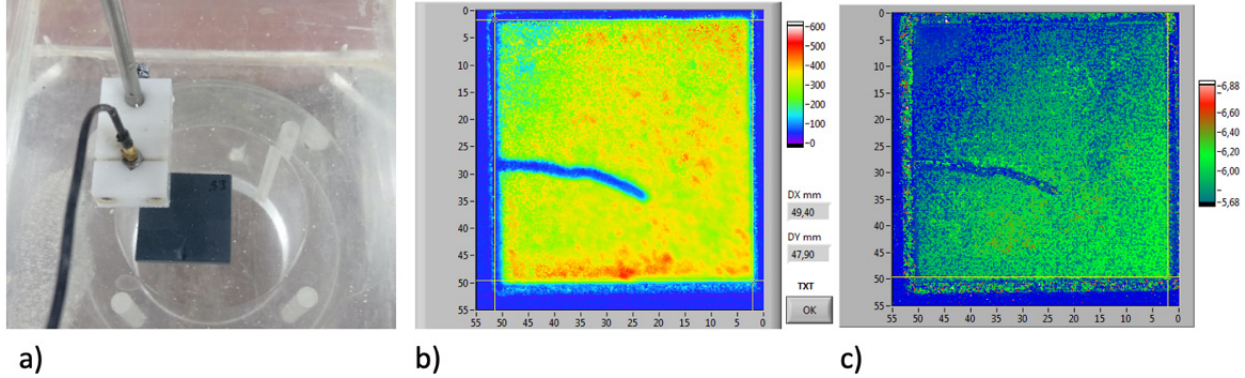
Materials 2021 , 14 , x FOR PEER REVIEW Figure 4. Ultrasonic inspection: ( a ) specimen (slab 23—see Table 2) undergoing ultrasonic mapping in pulse-echo mode, ( b ) amplitude map in C-scan model, and ( c ) amplitude map in D-scan mode. All images show the full 50 mm × 50 mm slab.